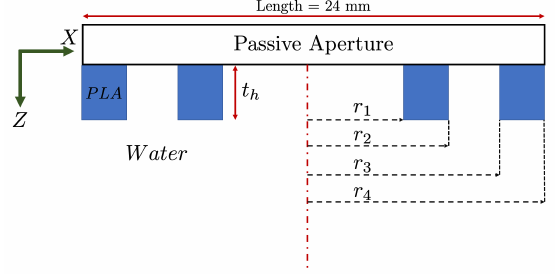
Figure 2. Phase-reversal (PR)-Fresnel zone plate (FZP) building